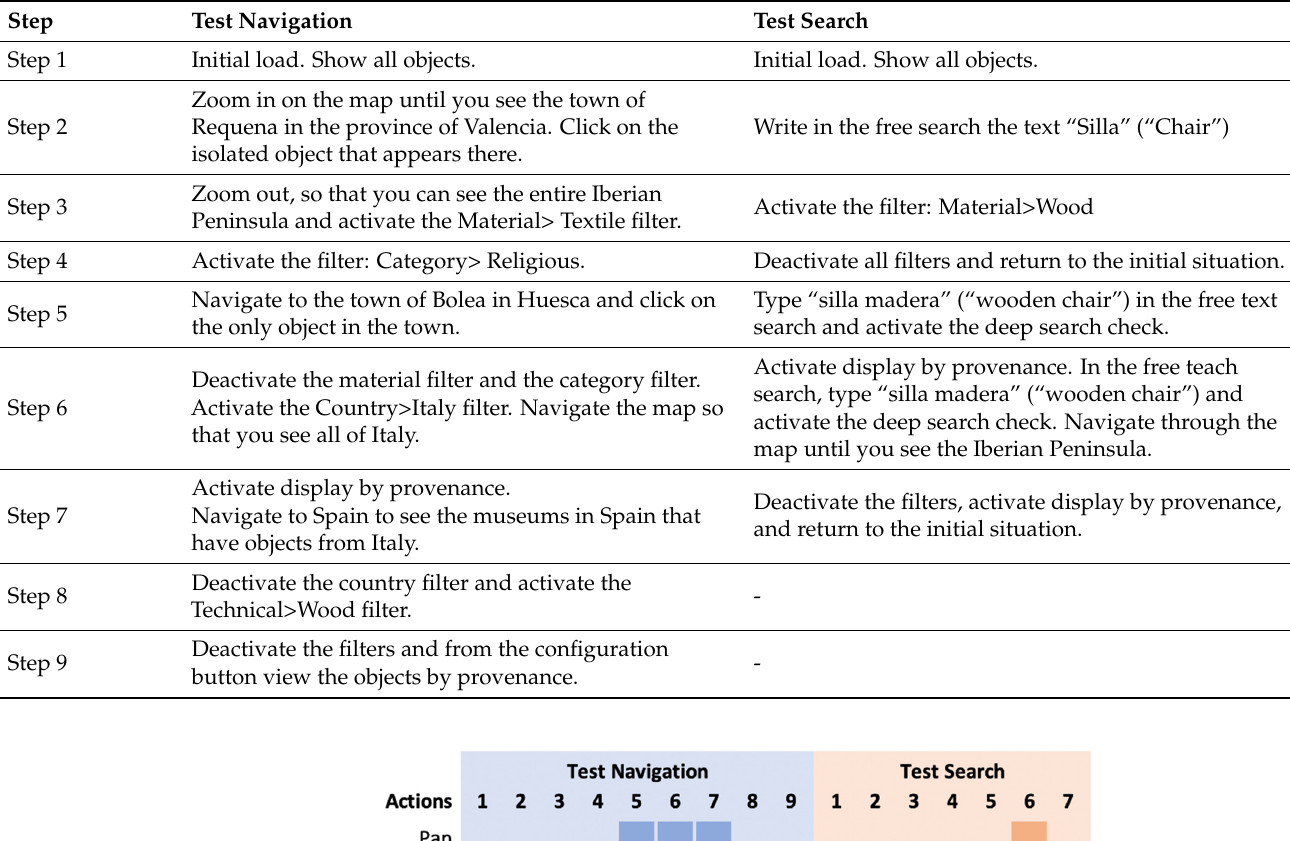
Table 3. Description of the stress test steps for Test Navigation and Test Search.